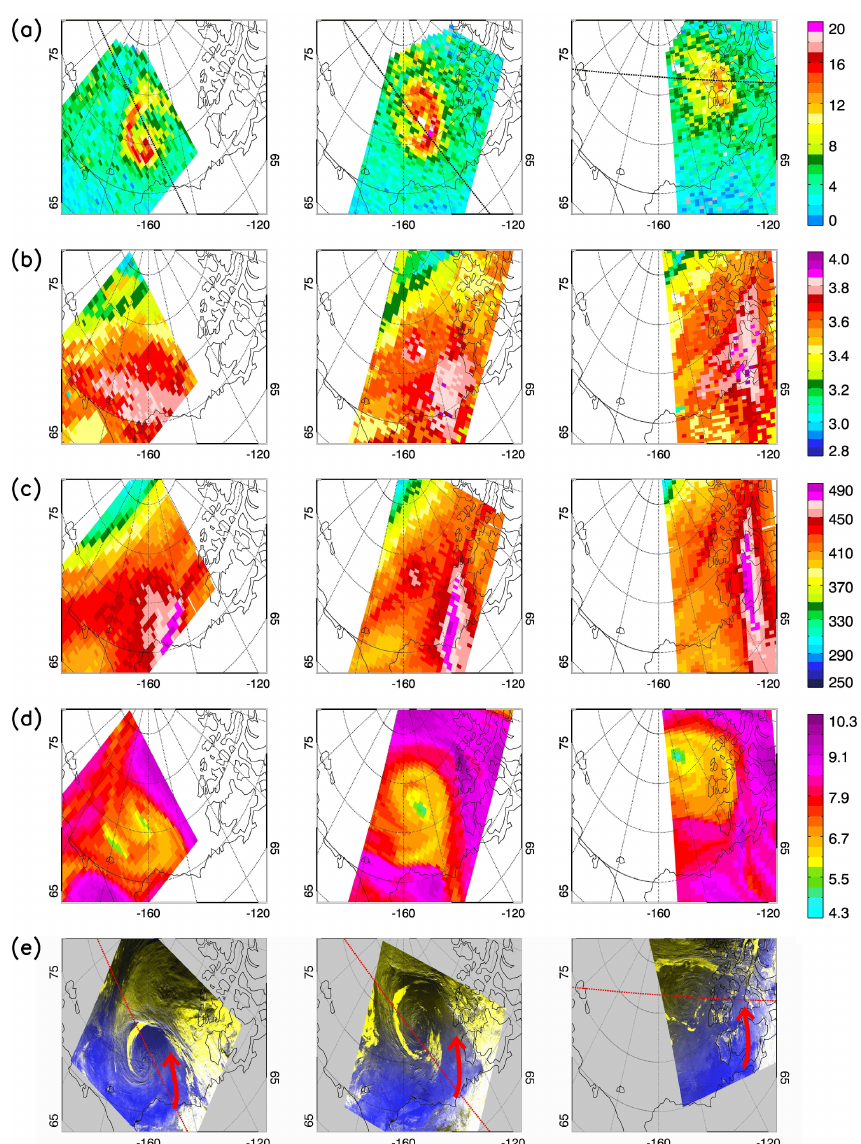
Figure 3. Satellite observations, together with parameters used for GOME-2 tropospheric BrO retrieval, of the BCTE showing (a) GOME- 2 BrO tropospheric VCD [10 13 moleccm − 2 ], (b) GOME-2 BrO stratospheric VCD [10 13 moleccm − 2 ], (c) GOME-2 ozone VCD [DU], (d) WRF tropopause height [km] and (e) MODIS false colour images. Shown from left to right are different development stages of the BCTE: onset (31 March 2011 at 23:30UTC for GOME-2 and WRF, 23:15UTC for MODIS), mature stage (1 April 2011 at 21:30UTC for GOME-2 and WRF, 22:20UTC for MODIS) and dissolving stage (2 April 2011 at 19:30 UTC for GOME-2 and WRF, 19:45UTC for MODIS). Red arrows plotted on top of MODIS false colour images indicate the location of the dry conveyor belt (see Sect. 4 for further details). The red dotted lines in MODIS false colour images and black dotted lines in GOME-2 BrO tropospheric VCD images correspond to CALIPSO tracks for the CALIOP observations shown in Fig.